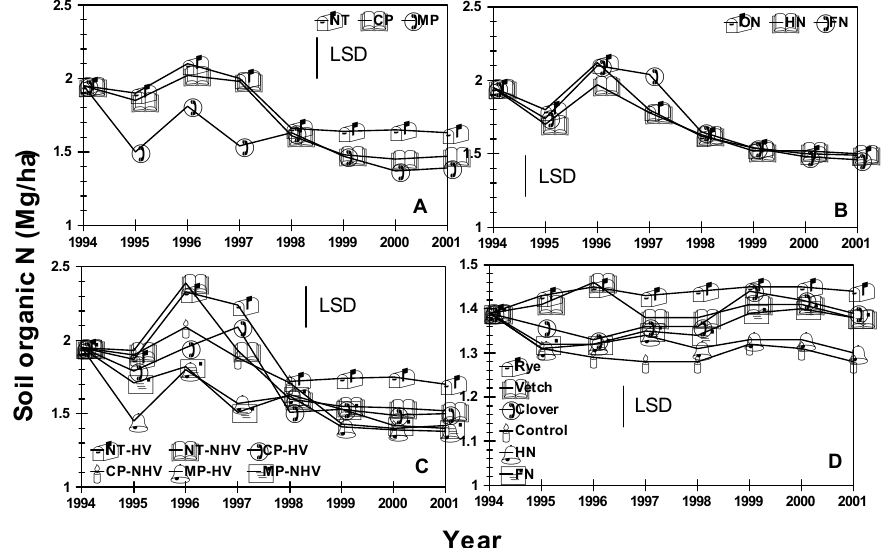
FIGURE 3 . Soil organic N concentration as influenced by tillage, cover crops, and N fertilization rates. (A, B, and C) NT denotes no- till; CP, chisel plowing; MP, moldboard plowing; HV, hairy vetch; NHV, no hairy vetch; ON, 0 kg N/ha; HN, 60–90 kg N/ha; and FN, 120–180 kg N/ ha. (D) Vetch denotes hairy vetch; clover, crimson clover; control, no cover crop or N rate; HN, 80–90 kg N/ha; and FN, 160–180 kg N/ha. LSD denotes least significant difference at p <